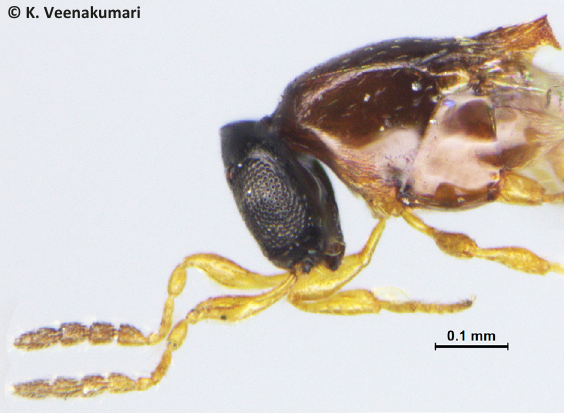
Image 2. Dorsally compressed mesosoma of Piestopleura